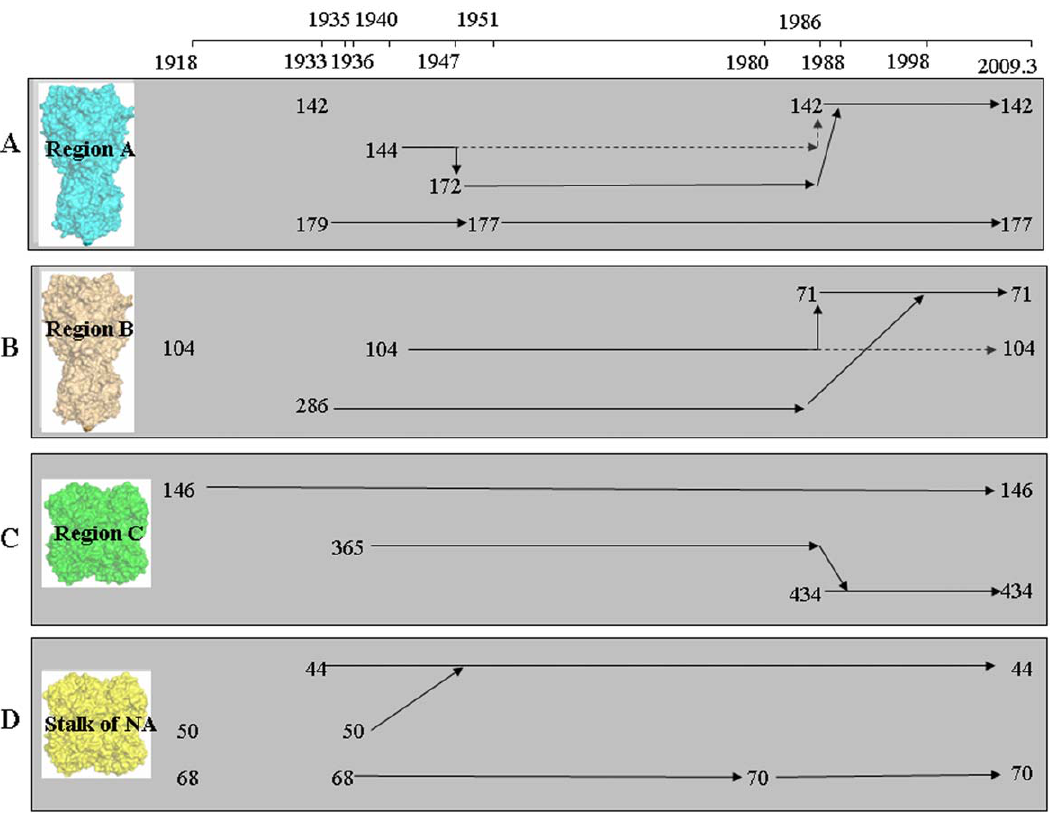
Figure 2. The alteration processes of glycosylation sites in some important regions of HA and NA. (A) The alteration process of glycosylation sites in region A (located at the receptor binding domain) of HA. (B) The alteration process of glycosylation sites in region B (located at the vestigial esterase domain) of HA. (C) The alteration process of glycosylation sites in region C (located around the enzymatic active site) of NA. (D) The alteration process of glycosylation sites on the stalk of NA. The dotted lines represented the superficial alterations based on genome-based analysis, while the corresponding full lines illustrated the possibly alteration processes after further analysis by homology modeling and in silico protein glycosylation.